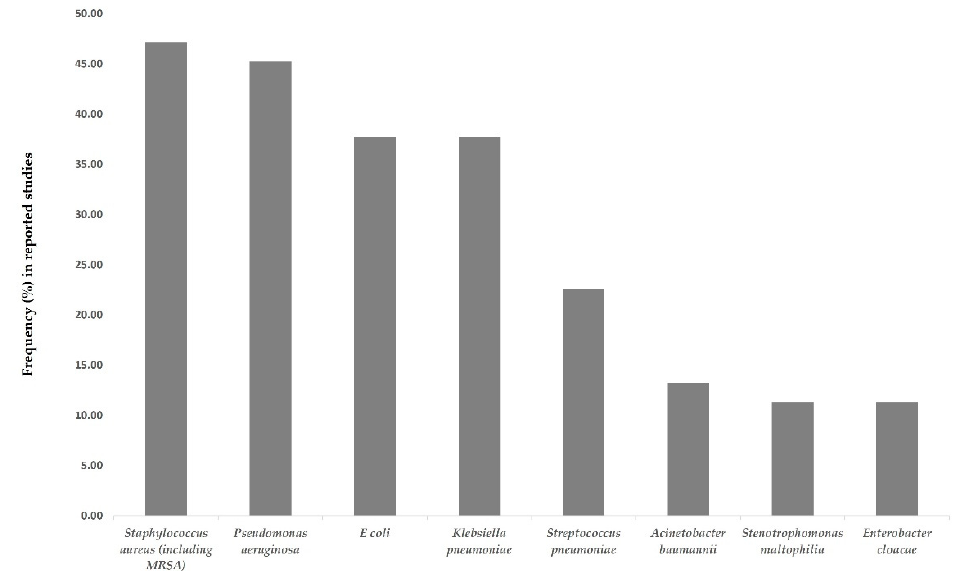
Figure 3. Frequently reported resistant pathogens in COVID-19